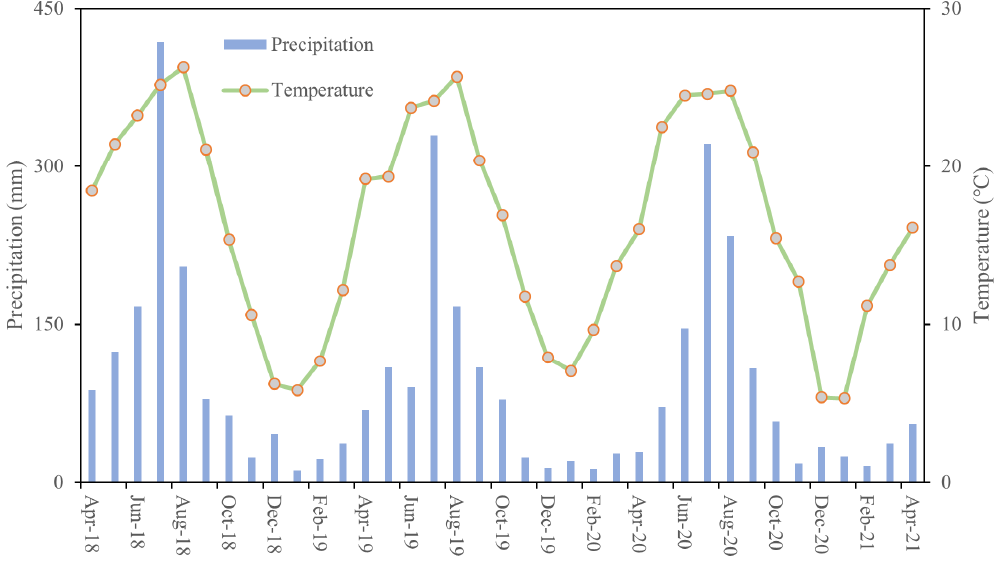
Figure 1. Monthly weather data of Chengdu city (China Meteorlogical Data Network). The bar graph represents the monthly average rainfall, and the line graph represents the monthly average temperature. Table 1. The soil texture and basic properties of 0–10 cm soil samples.